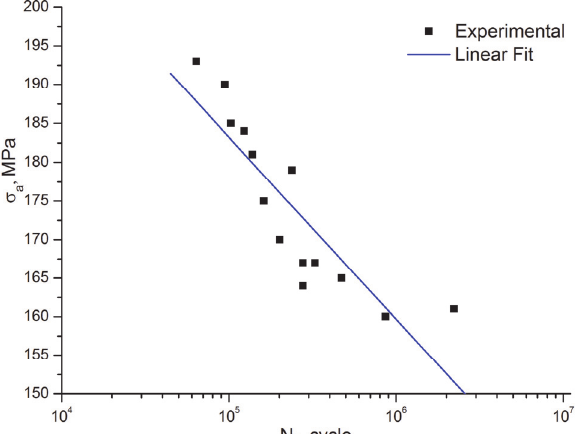
Figure 3: Basquin’s fatigue characteristics concerning the AlZn6Mg0.8Zr alloy loaded due to cyclic bending.